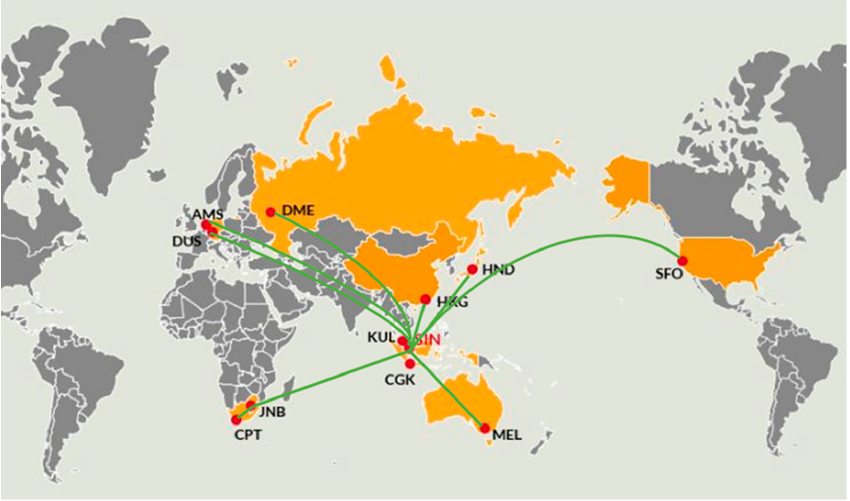
Figure 3. Singapore Airlines Airbus A350-900XWB aircraft routes as at 31 December 2016.